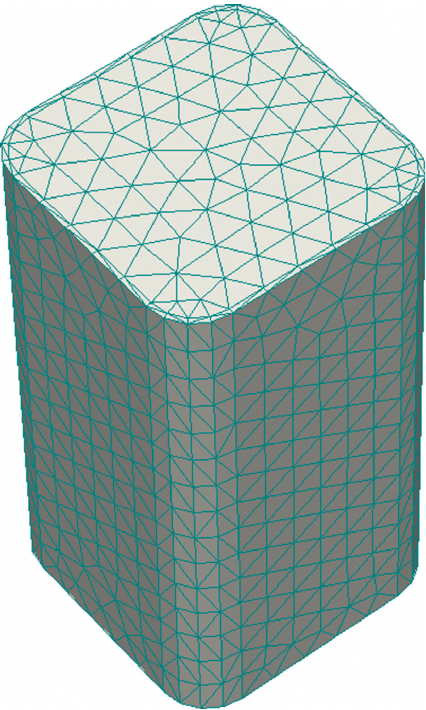
Figure 9: FEM model of the short RuC column.